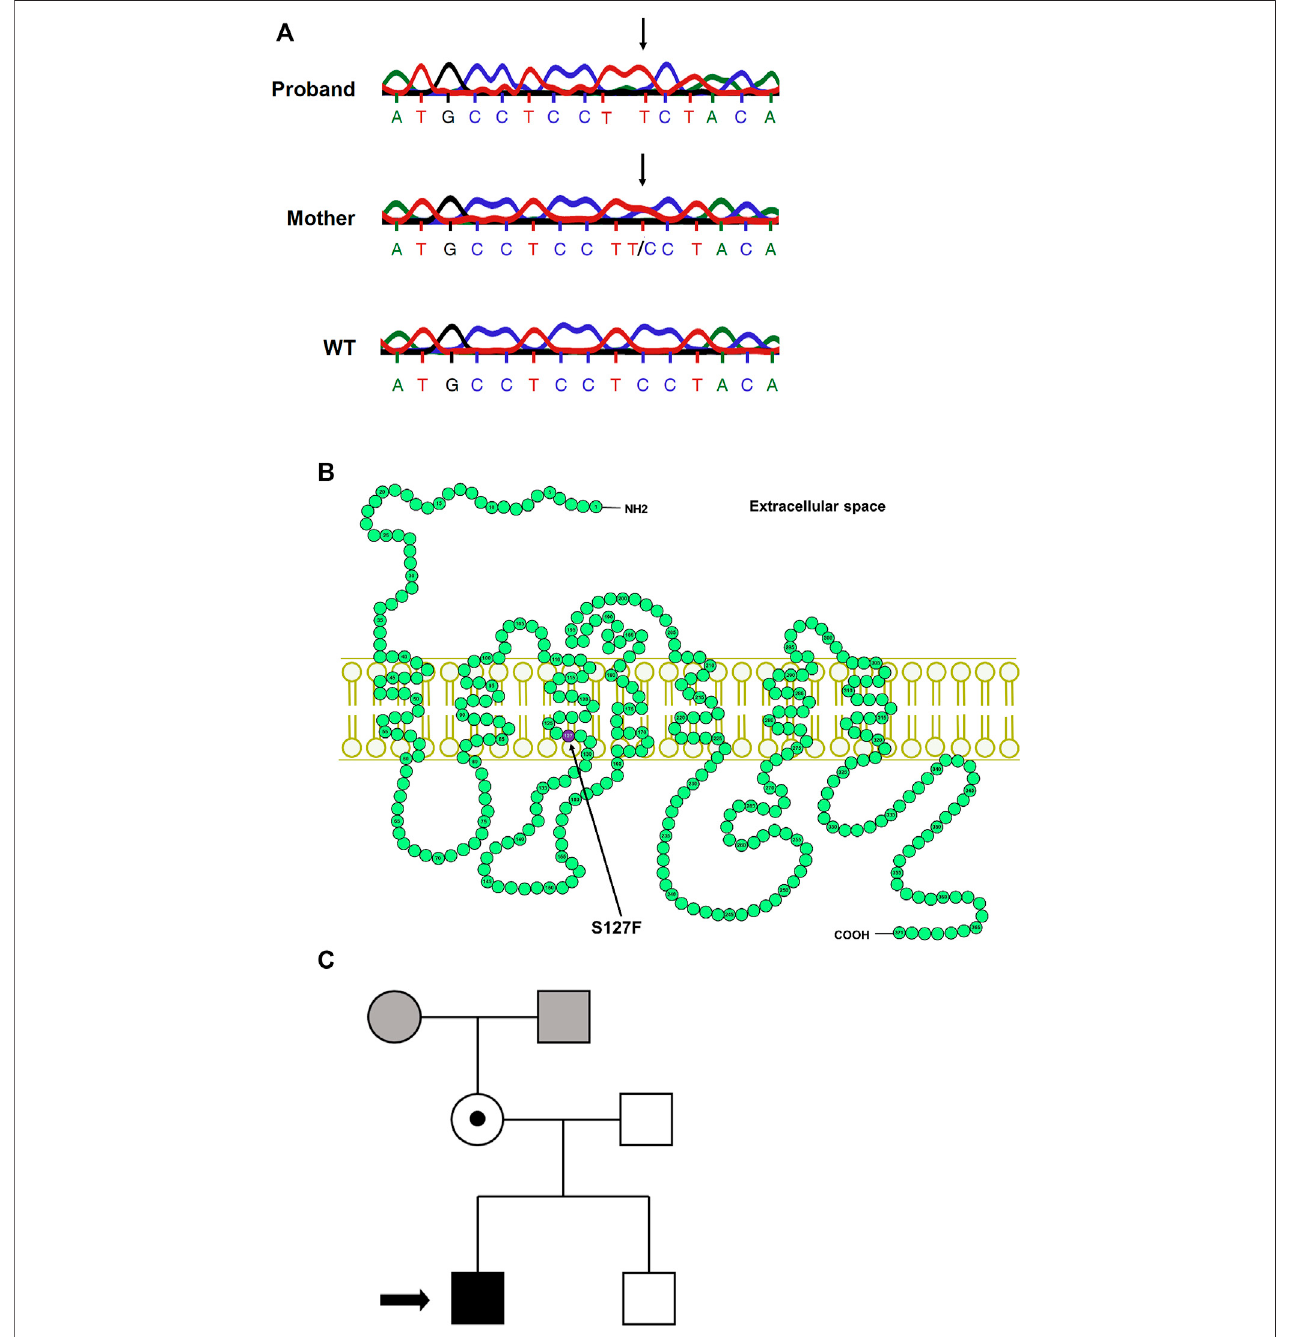
FIGURE 1 | Mutation analysis of the AVPR2 gene and the family pedigree. (A) The chromatogram of the Sanger sequencing of AVPR2 gene from the proband (upper panel), the mother of the proband (middle panel), and a healthy control individual (lower panel). The arrows indicate the mutation in the DNA sequences. (B) The schematic representation of thehuman V2vasopressin receptor. The arrow indicates the affected amino acid (purple circle) inthe third transmembranehelix ofthe V2R. (C) The arrowin thepedigree ofthefamily indicates theproband,thesolidblack square representsthemale individualwith theclassical symptoms ofNDIwhereas the heterozygous mother with subclinical NDI is represented by an open circle with a central dot. The mutation was not found in the brother of the proband, the genotypes of the maternal parents are not known (grey square and circle).